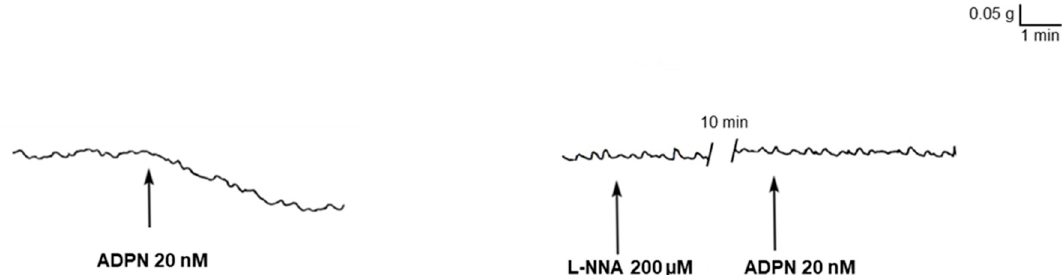
Figure 1. Lack of effects of adiponectin (ADPN) on carbachol (CCh)-precontracted gastric strips in the presence of L-N G -nitro arginine (L-NNA). Typical tracing ( left hand panel) showing the long-lasting and slight (note the magnitude of the amplification) decay of the strip basal tension caused by 20 nM ADPN. Such an effect, already appreciable within 1 min of contact time, persists up to 30 min (longer time not observed). When ADPN is added to the bath medium 15 min after the NO synthesis inhibitor L-NNA (200 μ M), it is no longer able to induce the decay of the strip basal tension ( right hand panel). Traces obtained from two different preparations.